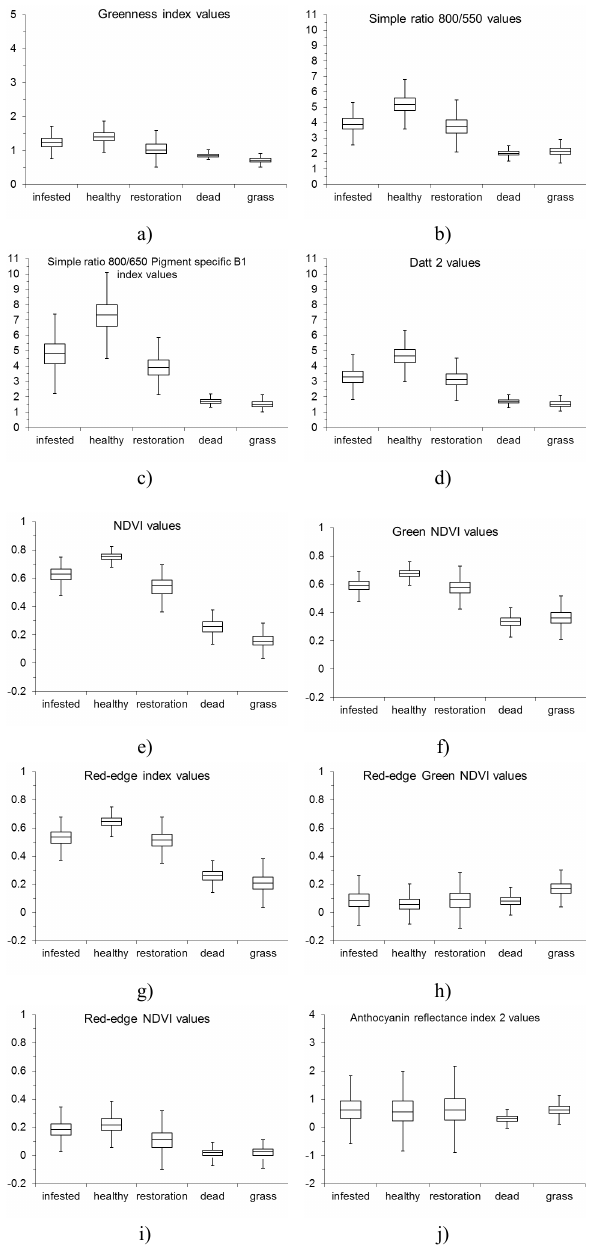
Figure 5. Distribution of values of the selected vegetation indices in tested categories of forest